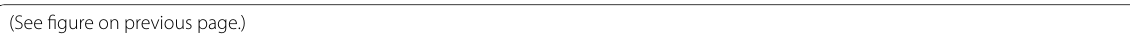
(See figure on previous page.) Fig. 4 Sequential splitting left and right edge of Chr2-6 replaced transformants. a Two splitting modules (One module synthesized from the plasmid pSJ70 contained CgHIS3 and the other module synthesized from the plasmid p3121 contained CEN4 as a centromere) were introduced into the host strain SJY 576 (Chr2-6 region replaced transformants) to split left edge of CgLEU2. Bottom part of a represents gel electrophoresis of colony PCR and Lane 1 to 10 represents 10 independent transformants were checked to amplify 1 kb band denoting the left edge of CgHIS3 and right edge of CgLEU2 . Primers used for colony PCR are illustrated in a . b After splitting left edge of CgLEU2 in Chr2-6 region replaced transformants (SJY 577), we tried to split sequentially the right edge of CgLEU2 . 2 splitting modules (One module synthesized from the plasmid pSJ23 contained URA3 and another module synthesized from the plasmid p3121 contain CEN4 as a centromere) were introduced into SJY 577 to split right edge of CgLEU2 . Bottom part of b represents gel electrophoresis of colony PCR and 5 independent transformants were checked for amplifying 1.5 kb band denoting the right edge of CgLEU2 and left edge of URA3 . Primers used for colony PCR are illustrated in b